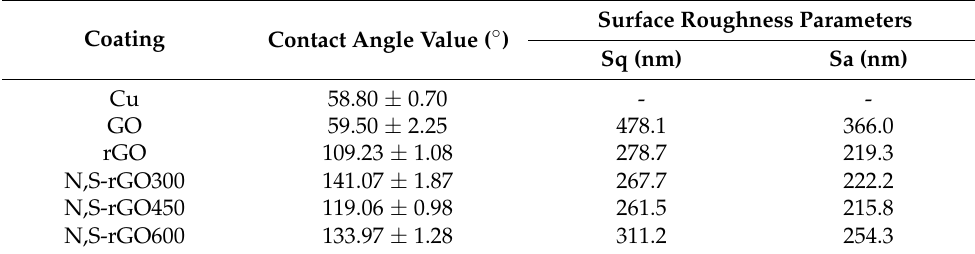
Table 3. Contact angle values and surface roughness parameters for graphene